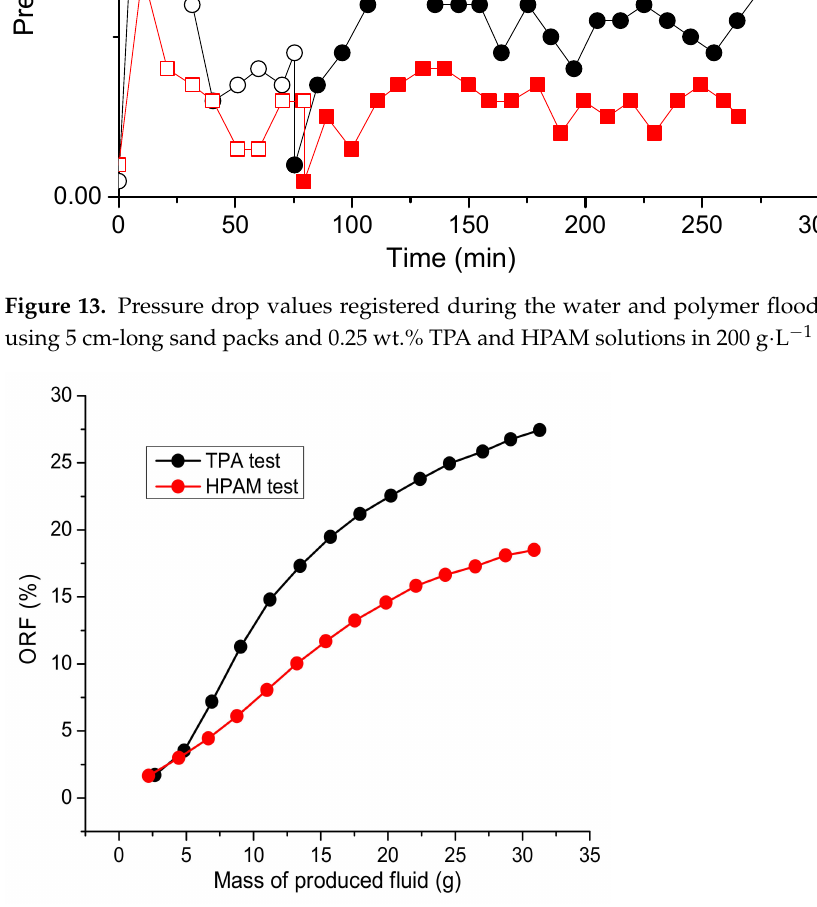
Figure 14. Oil recovery factor versus the mass of fluid produced as registered during the water and polymer flooding experiments, using 5 cm-long sand packs and 0.25 wt.% TPA and HPAM solutions in 200 g · L − 1